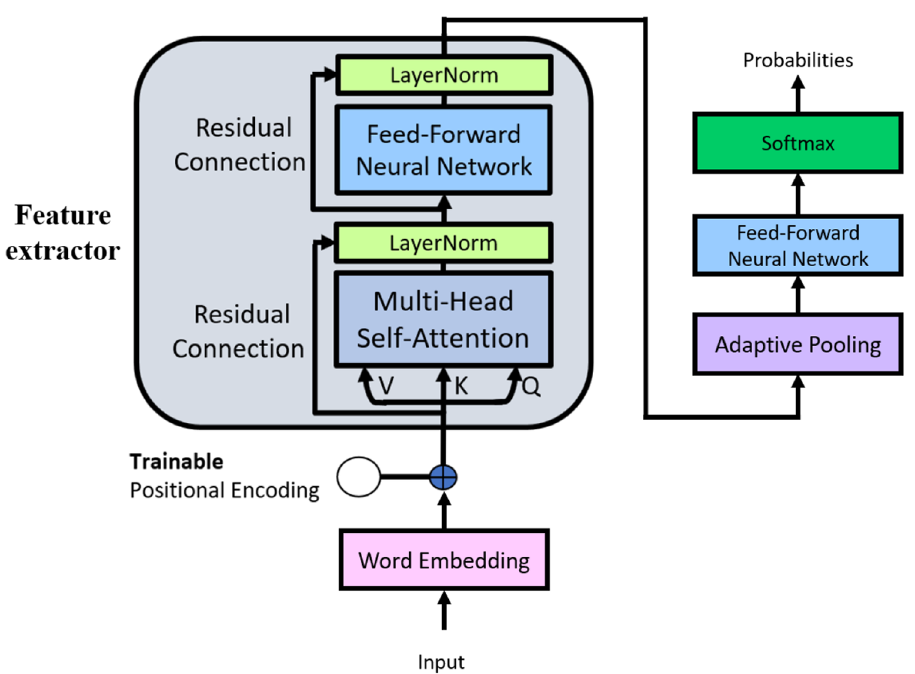
Figure 1. Overview of the proposed deep-learning-based